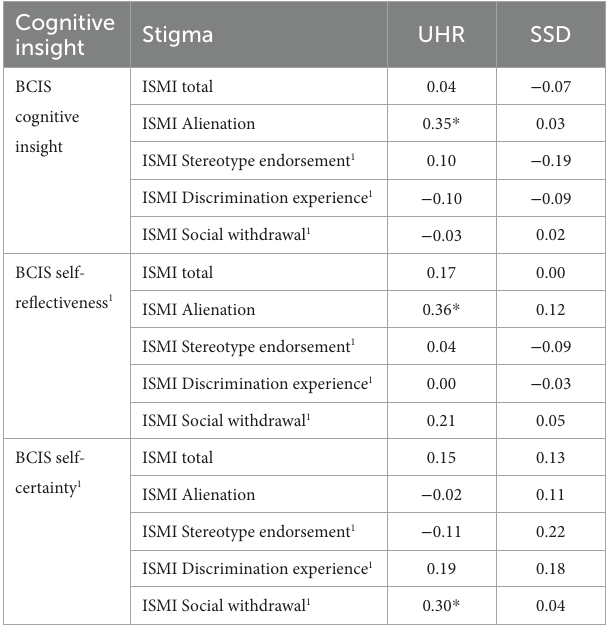
TABLE 3 Correlations between cognitive insight and stigma in participants with UHR status ( n = 43) and participants with a schizophrenia spectrum disorder ( n =